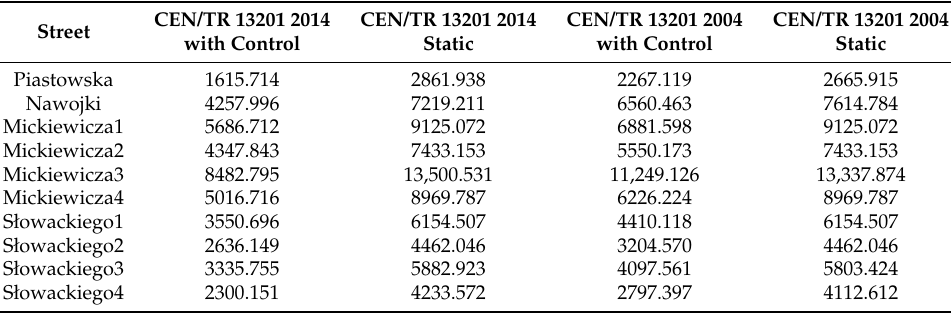
Figure 4. Energy consumption with dynamic control for given street segments. Table 5. Energy consumption (in kWh) when redesigned and with added dynamic